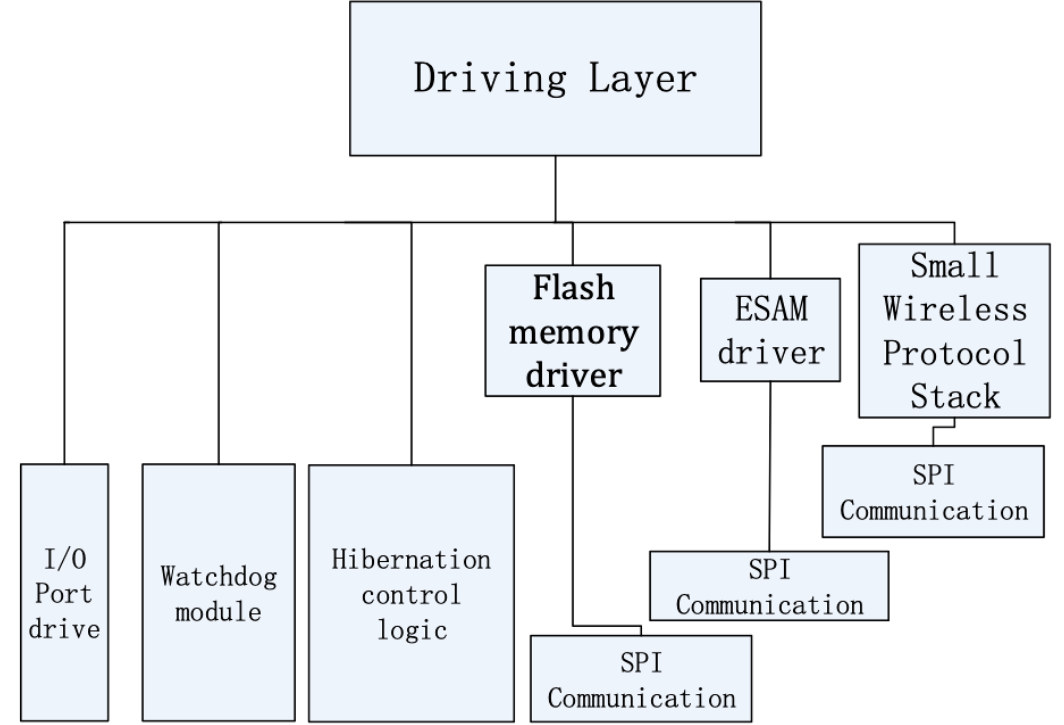
Figure 4. Module division diagram of drive